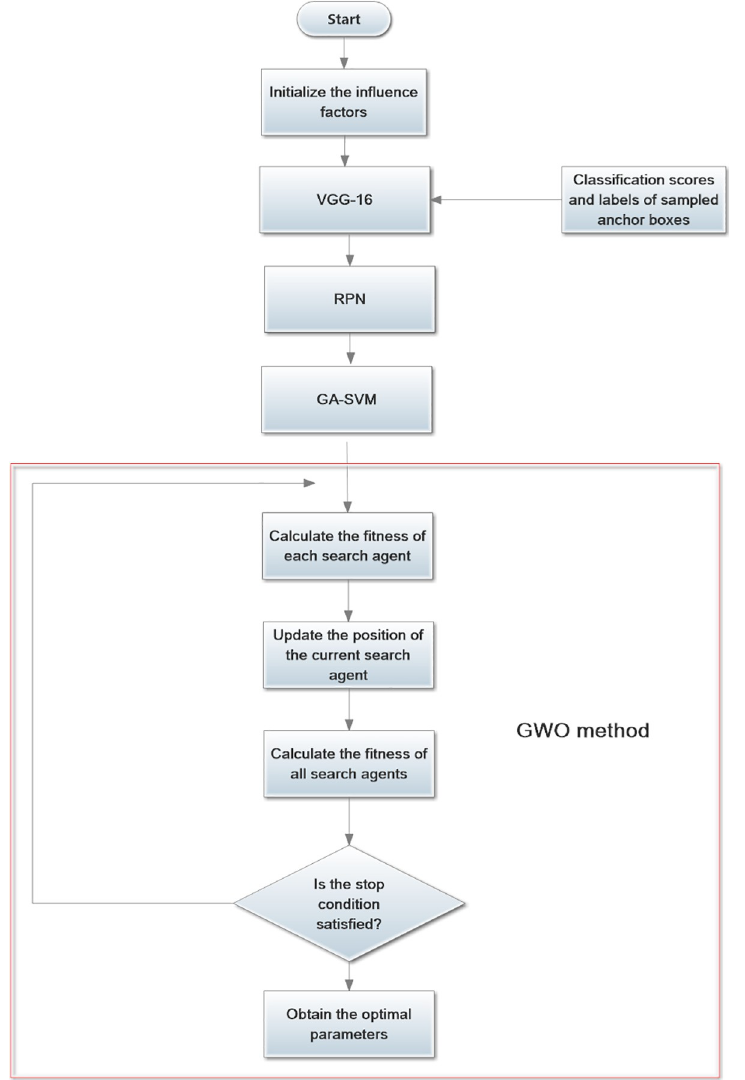
Fig 11. Flowchart of the parameter optimization process with